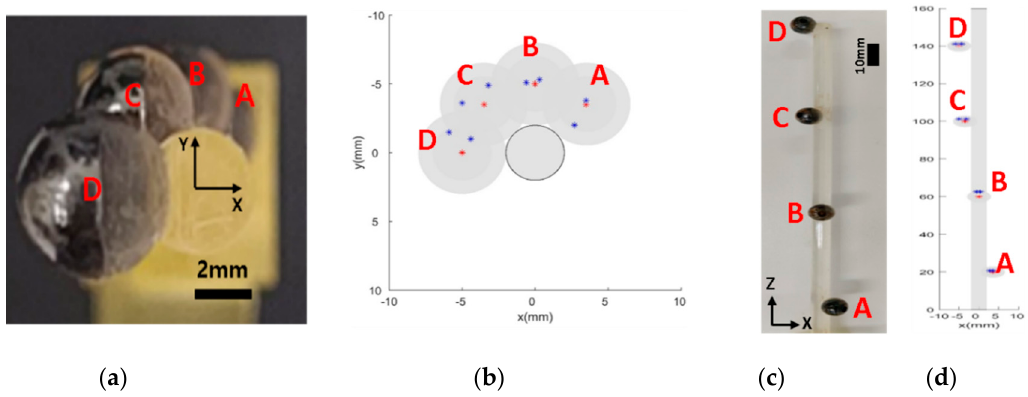
Figure 9. Phantom corresponding to multiple positions. The red and blue points in ( b ) and ( d ) indicate the geometric center point and the measured points of the MNP group through a 3D scan, respectively; ( a ) frontal view of the phantom, ( b ) frontal view of the 3D imaging result, ( c ) sidelong view of the phantom, and ( d ) sidelong view of the 3D imaging result.